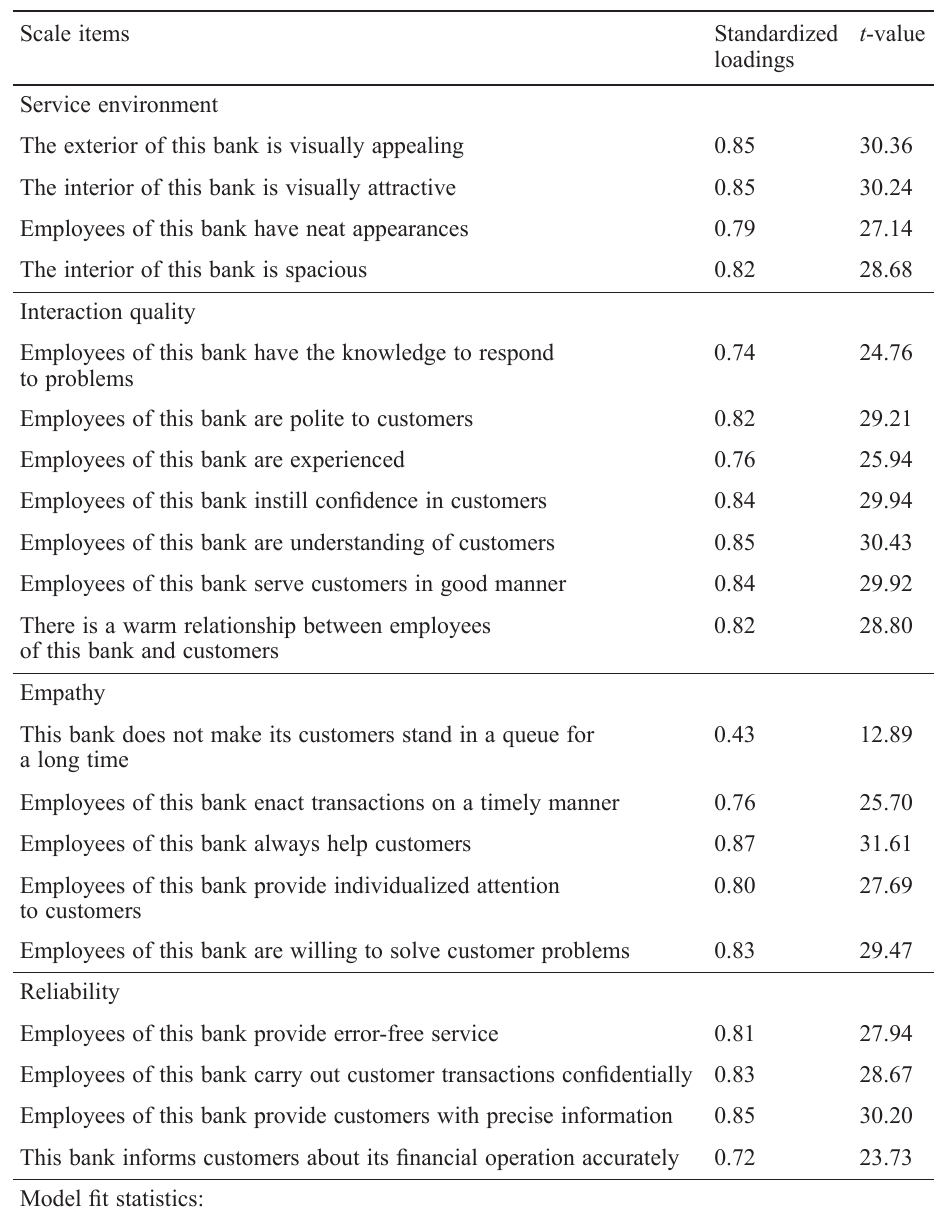
Table 1. Scale items and con fi rmatory factor analysis